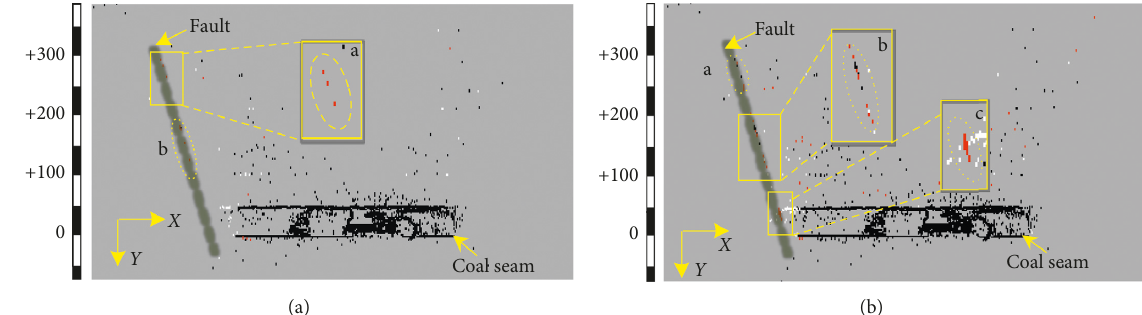
Figure 7: Diagram of acoustic emission events representing microcracks around the fault zone. (a) The state when the working face advances 350m. (b) The state when the working face advances